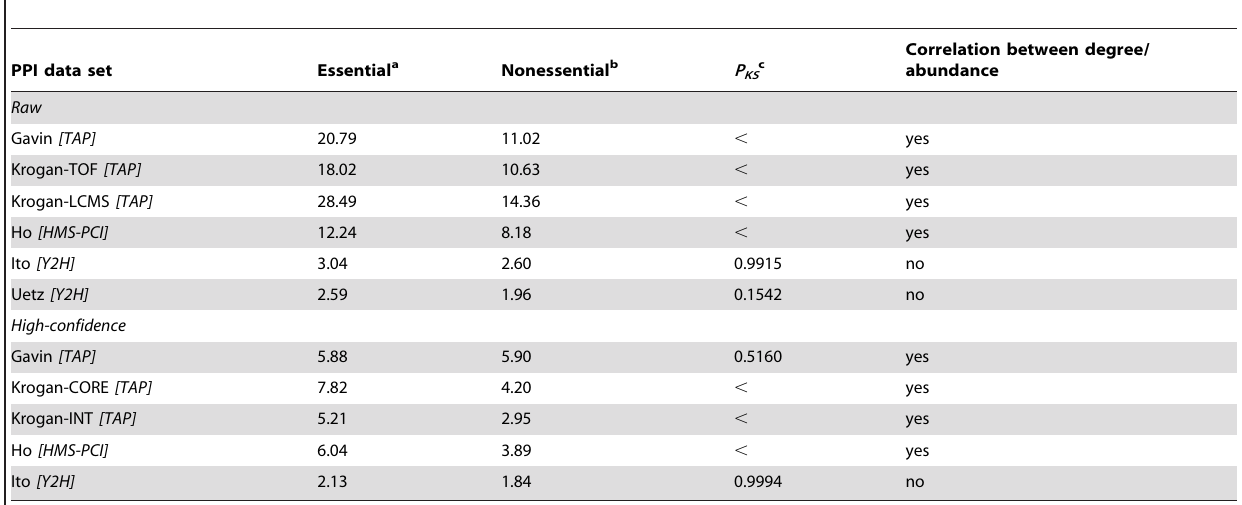
Table 4. Tests of difference beween degree distributions of essential and nonessential proteins in raw and high-confidence yeast PPI data